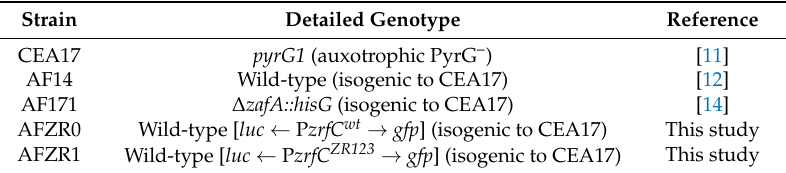
Table 1. Aspergillus fumigatus strains used in this study. Genes in brackets were reintroduced into the A. fumigatus genome by targeting them at the intergenic region between the AFUA_2G08360 ( pyrG ) and AFUA_2G08350